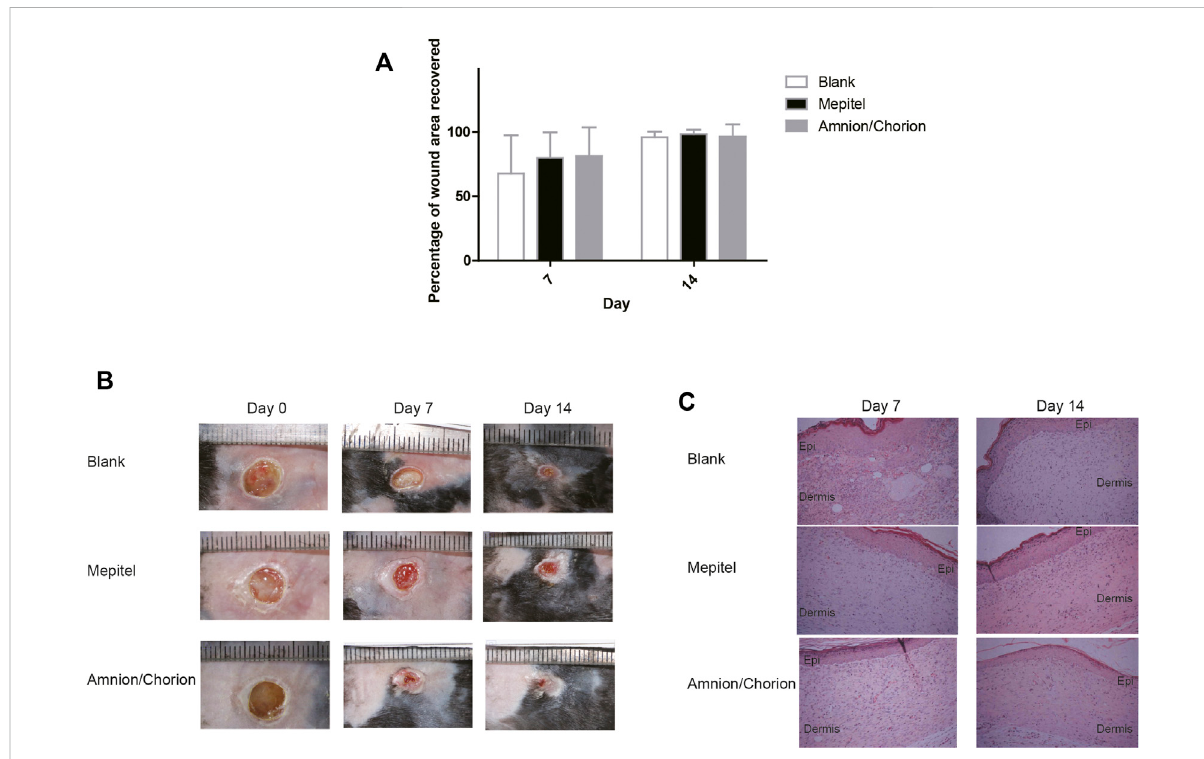
FIGURE 5 The skinrepaircapacityofamnion/chorion complex. (A) Therewasatendency ofaccelerated recovery intermsof woundarea fortheamnion/ chorion complex graft group compared with the blank control on day 7, although the data was not statistically different. Data represent mean ± SD and n =20for day7and n =10for day14.One-wayANOVAwithTukey ’ s posthoc testwasusedfor thecalculation. (B) Representativephotosofthe wound recovery of the animal model. (C) Histology results of the recovered wound area. There was no apparent difference between each group.